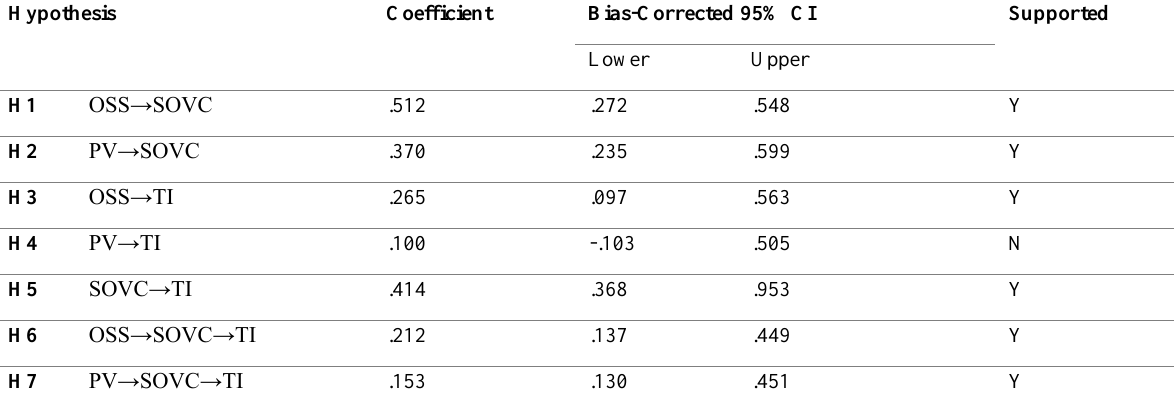
Table 4: Summary of results on hypothesis